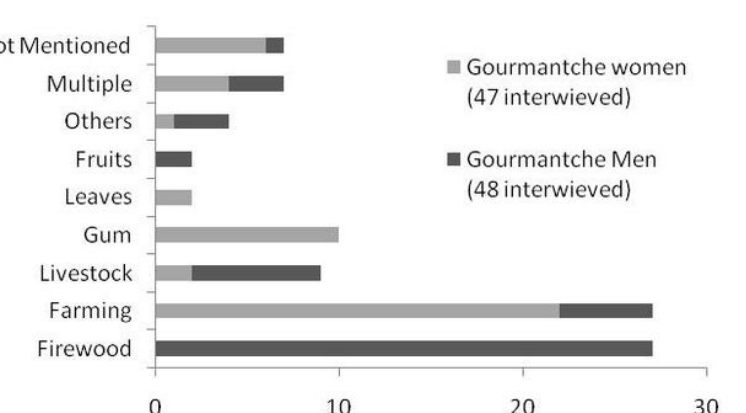
Fig A3.1: The interviewed Gourmantches ranked SES functions according to their importance in their incomes.